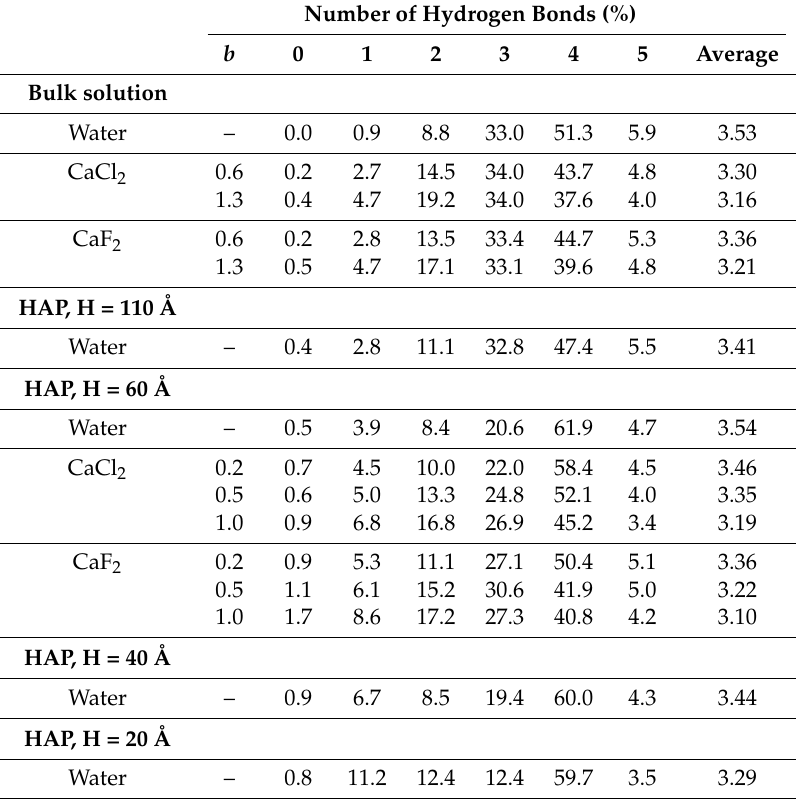
Table 2. The distribution of the number of hydrogen bonds per water molecule. Results obtained from MD simulations of bulk water, aqueous CaCl 2 solutions, water within HAP nanopores of different sizes (20 Å ≤ H ≤ 110 Å), and CaCl 2 and CaF 2 solutions within the HAP nanopores with H = 60 Å. The values given are percentages of molecules with the given number of hydrogen bonds. Concentration in mol · kg − 1 ( b